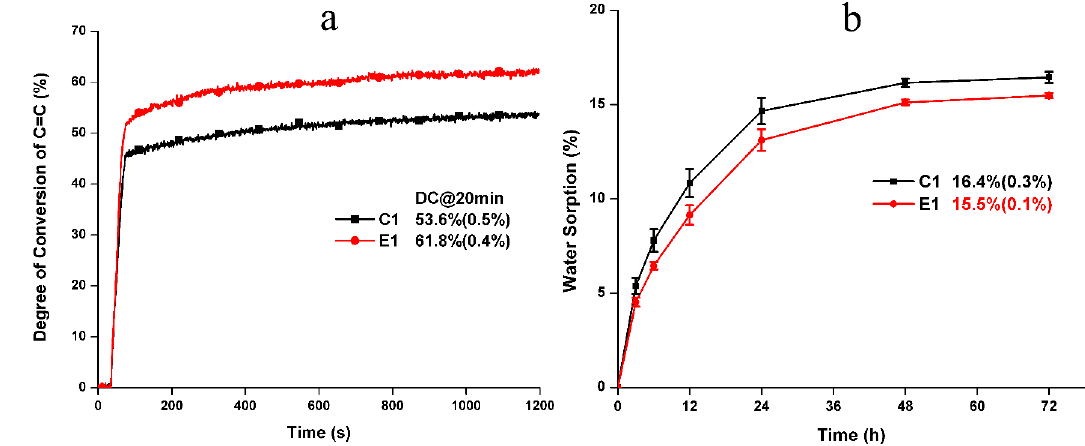
Figure 1 . Real-time degree of conversion of C=C bond ( a ) and the water sorption ( b ) of the control Figure 1. Real-time degree of conversion of C = C bond ( a ) and the water sorption ( b ) of the control and experimental formulations. and experimental